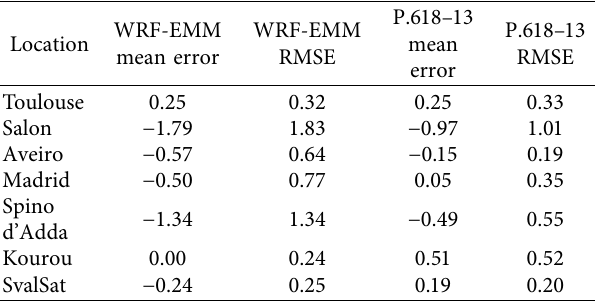
Table 4: ITU metric error analysis between results obtained from WRF-EMM simulations and from Rec. ITU-R